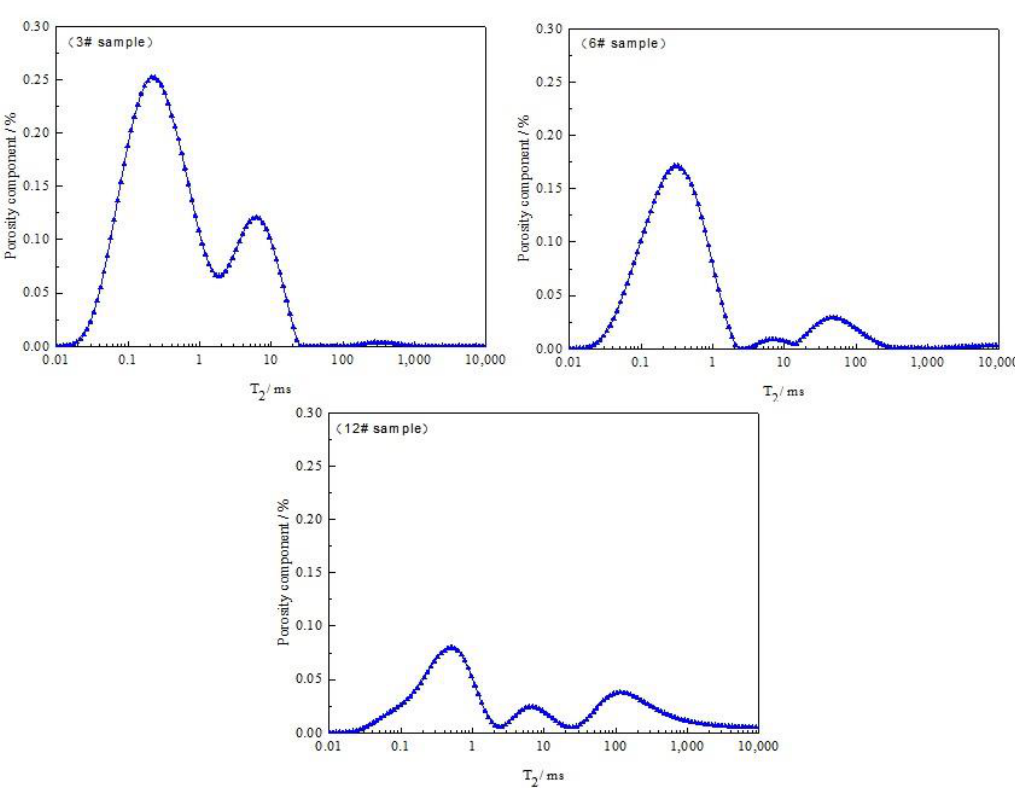
Figure 6. Shale NMR at 21 MHz.